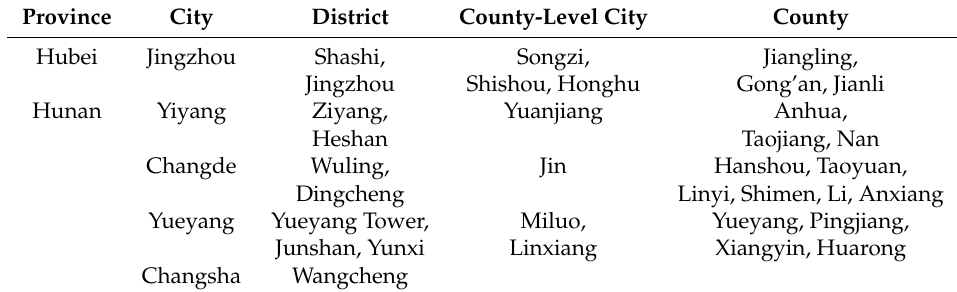
Table 1. Research area of the urban agglomeration of Dongting Lake Ecological Economic Zone (UADLEEZ). Province